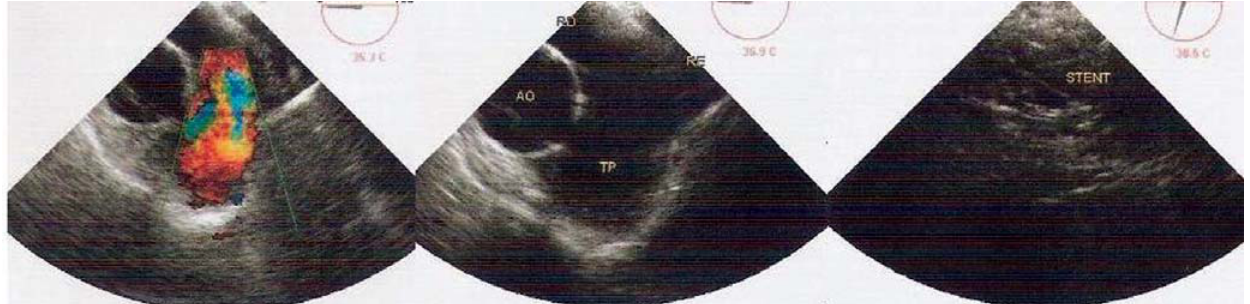
Fig. 2 - Ecocardiografia transesofágica pós-operatória demonstrando ausência de shunt aorto-pulmonar após implante da endoprótese